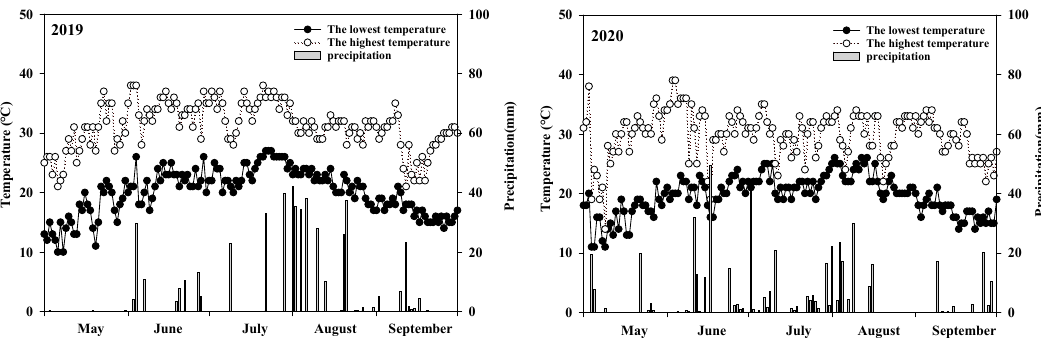
Figure 1. The daily precipitation and average temperature for the 2019–2020 summer maize growth period (May–September) in Yuanyang county (34°55 ′ N, 113°36 ′ E), Xinxiang city, Henan Province.